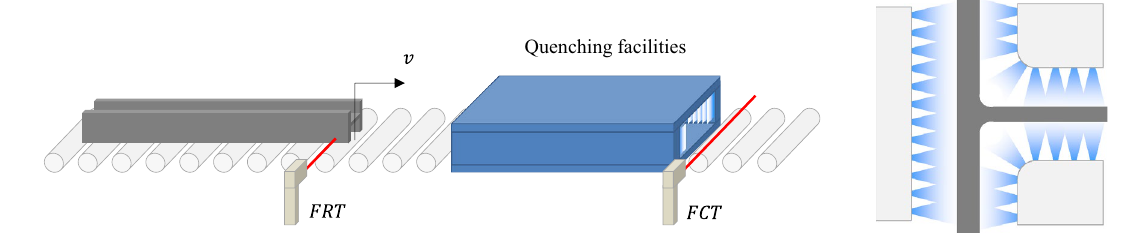
Figure 3. Quenching process for hot-rolled H-beams.